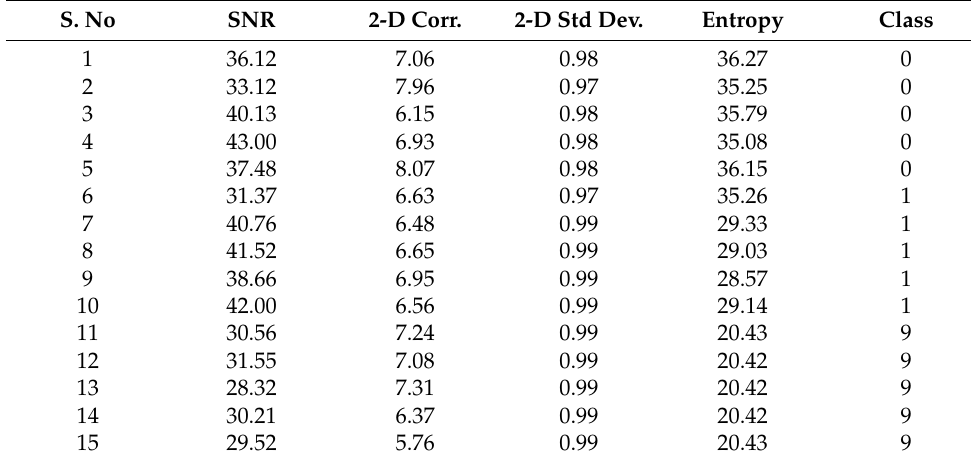
Table 3. Sample features selected using TLBO optimization.